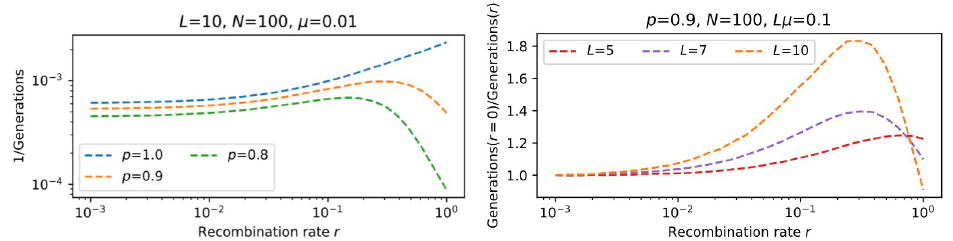
Fig 12. Fraction p and sequence length L impact on the time to full discovery in the fsm . A : Reciprocal of the time to full discovery is shown as a function of recombination rate for different values of the fraction p of viable genotypes. B : Relative change in the reciprocal of the time to full discovery for different values of the sequence length L and fixed genome-wide mutation rate U = Lμ .